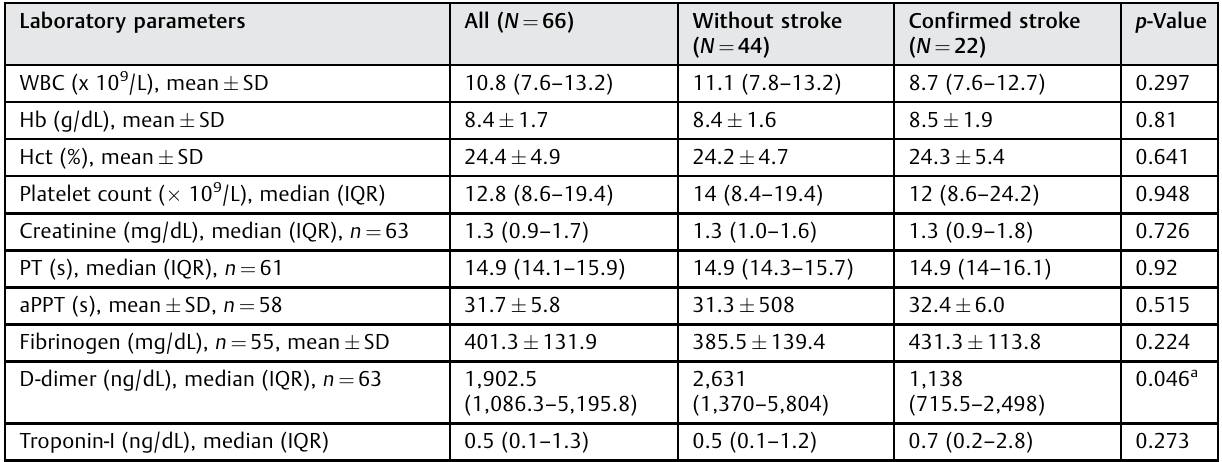
Table 2 Routine laboratory parameters in iTTP patients with or without imaging-con fi rmed ischemic stroke Laboratory parameters